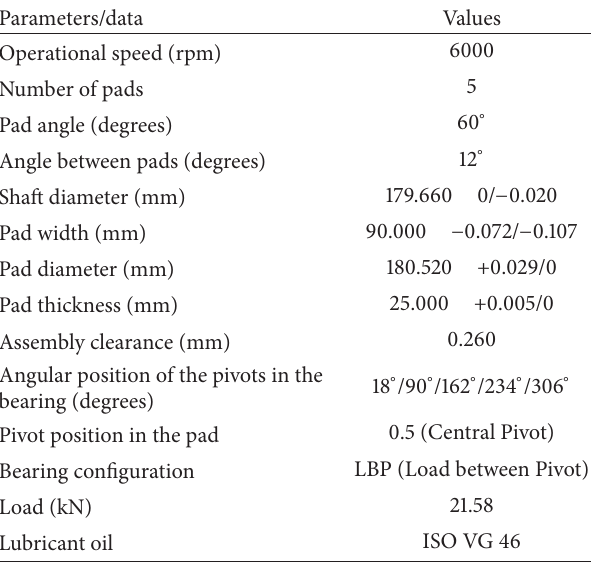
Table 1: Geometric parameters and operational condition of the